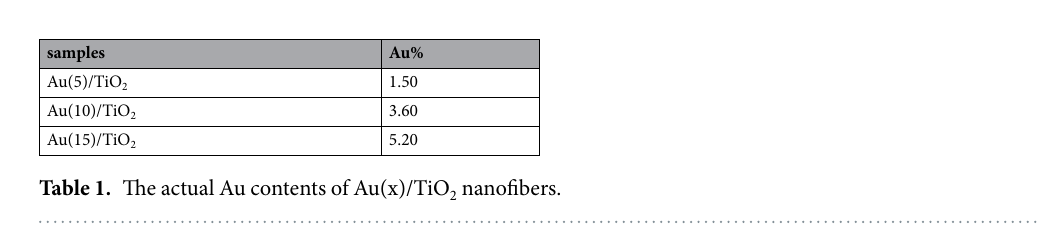
Figure 3. Normalized UV-Vis diffuse reflectance spectra of the pure TiO 2 nanofibers, Au(5)/TiO 2 nanofibers, Au(10)/TiO 2 , Au(15)/TiO 2 nanofibers.